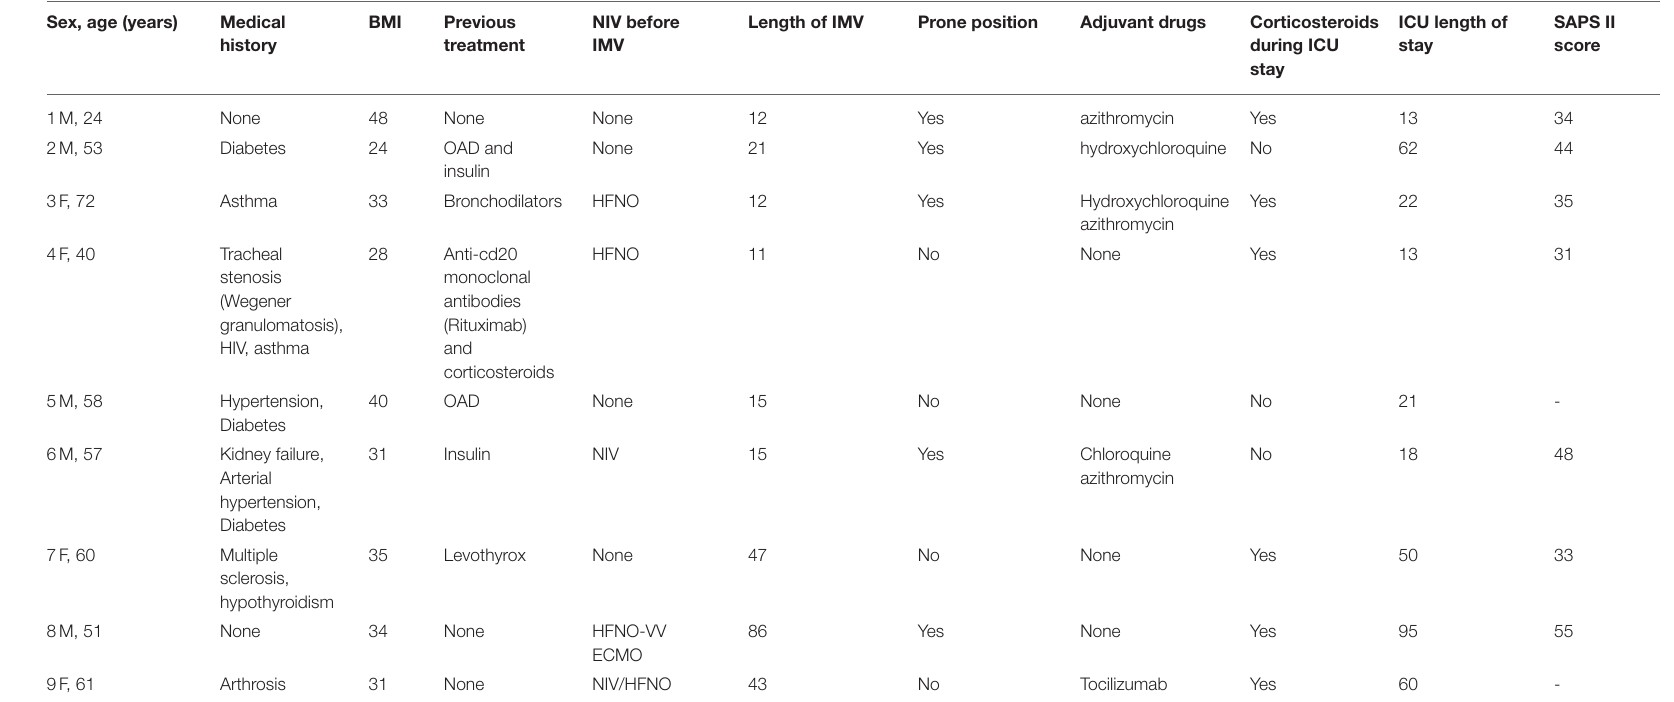
TABLE 1 | Patients’ characteristics.